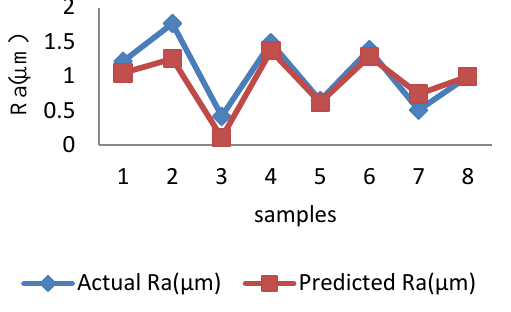
Fig. 7. Comparison of Rmax values obtained from actual measurements and ANN method-(sample No. Vs